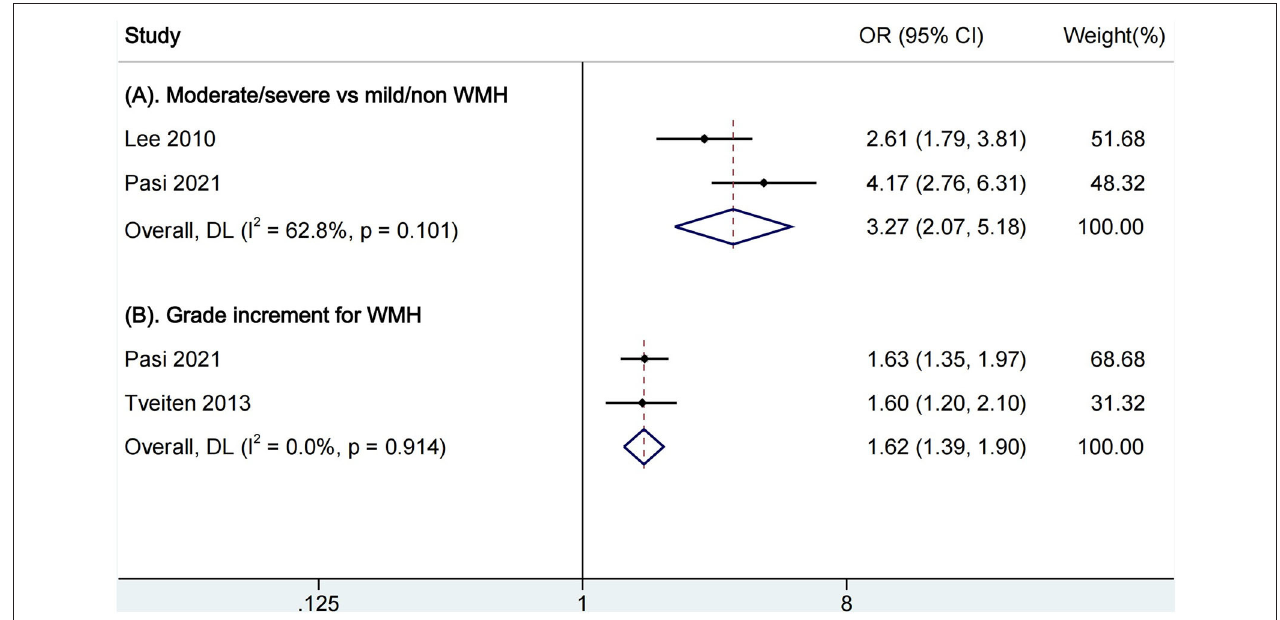
FIGURE 3 | Pooled analysis of relationship between WMH and all-cause mortality. (A) Comparison of functional outcomes between moderate/severe and none/mild WMH; (B) Ordinal increase in a WMH grade. WMH, white matter